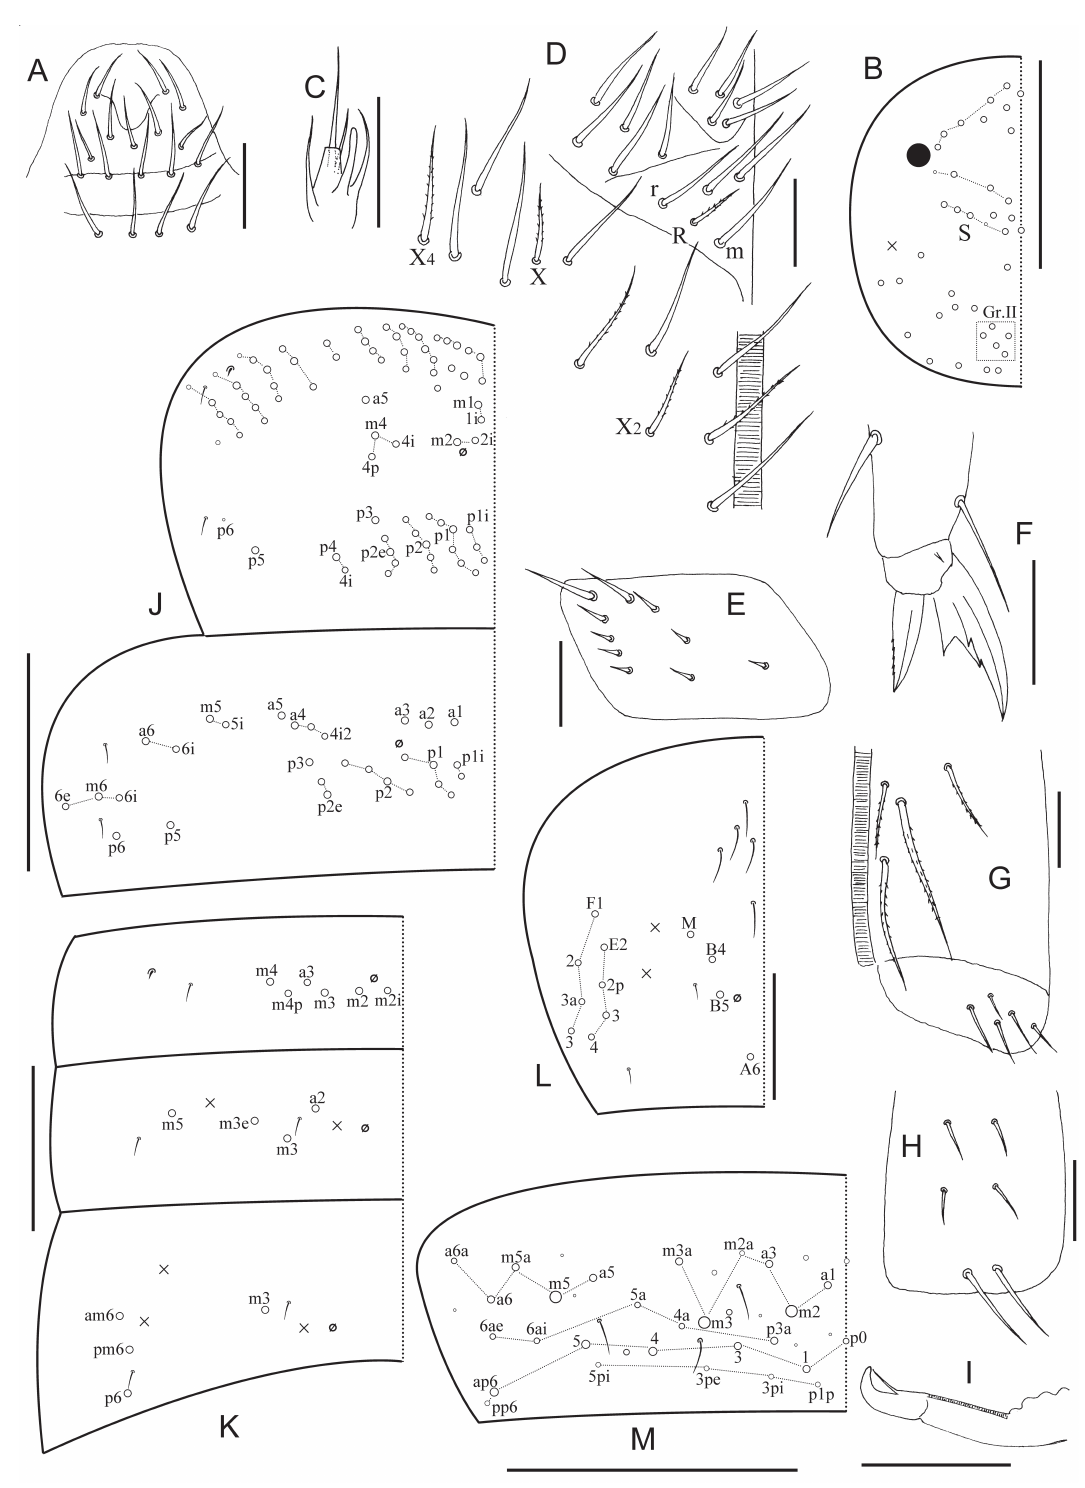
Fig. 8. Coecobrya oculata sp. nov. A . Labrum. B . Dorsal cephalic chaetotaxy. C . Lateral process of labial palp. D . Chaetae on the ventral side of head. E . Trochanteral organ, ventral view. F . Hind claw. G . Anterior face of ventral tube and lateral flap. H . Posterior face of ventral tube. I . Mucro. J . Thoracic chaetotaxy. K – M , Abdominal chaetotaxy. K . Abd. I–III. L . Abd. IV. M . Abd. V. Scale bars: A, C–I = 20 μm; B, J–M = 100